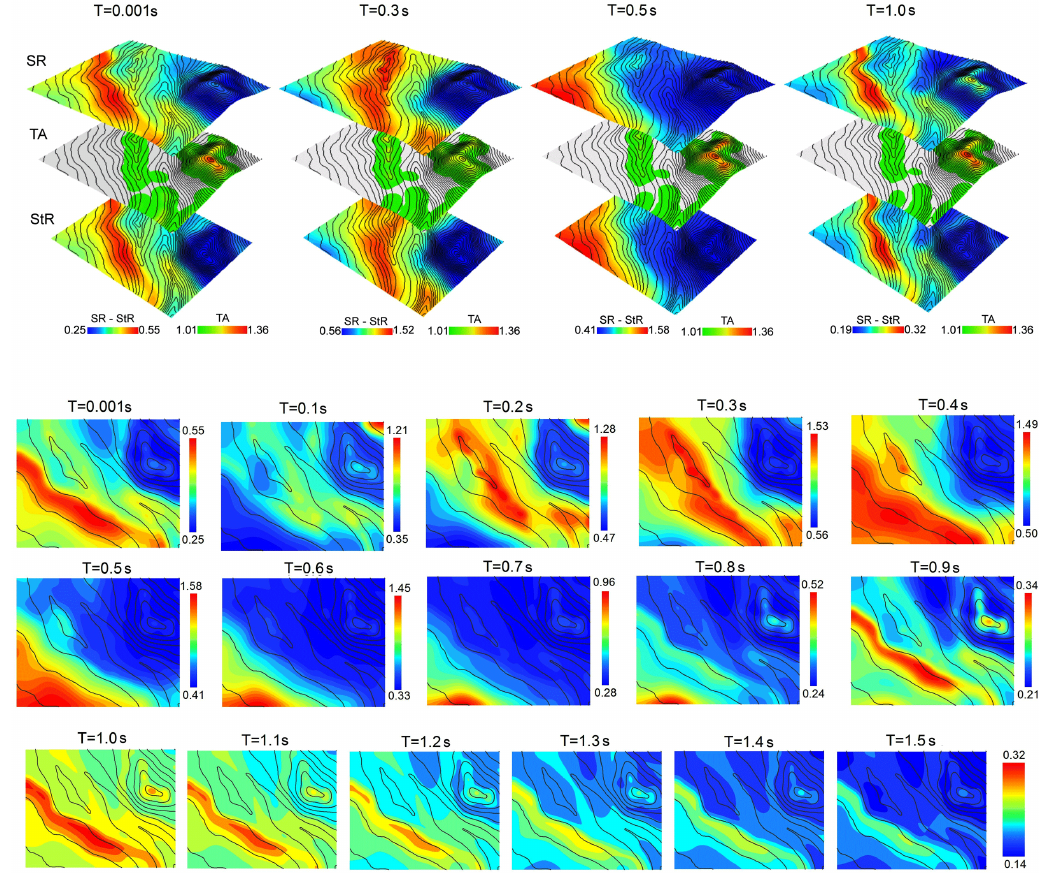
Figure 9. Set of seismic response maps for different periods. The combined effect of the stratigraphic and topographic features are shown at the top of the figure; StR is the stratigraphic seismic response, TA is the topographic amplification and SR is the seismic